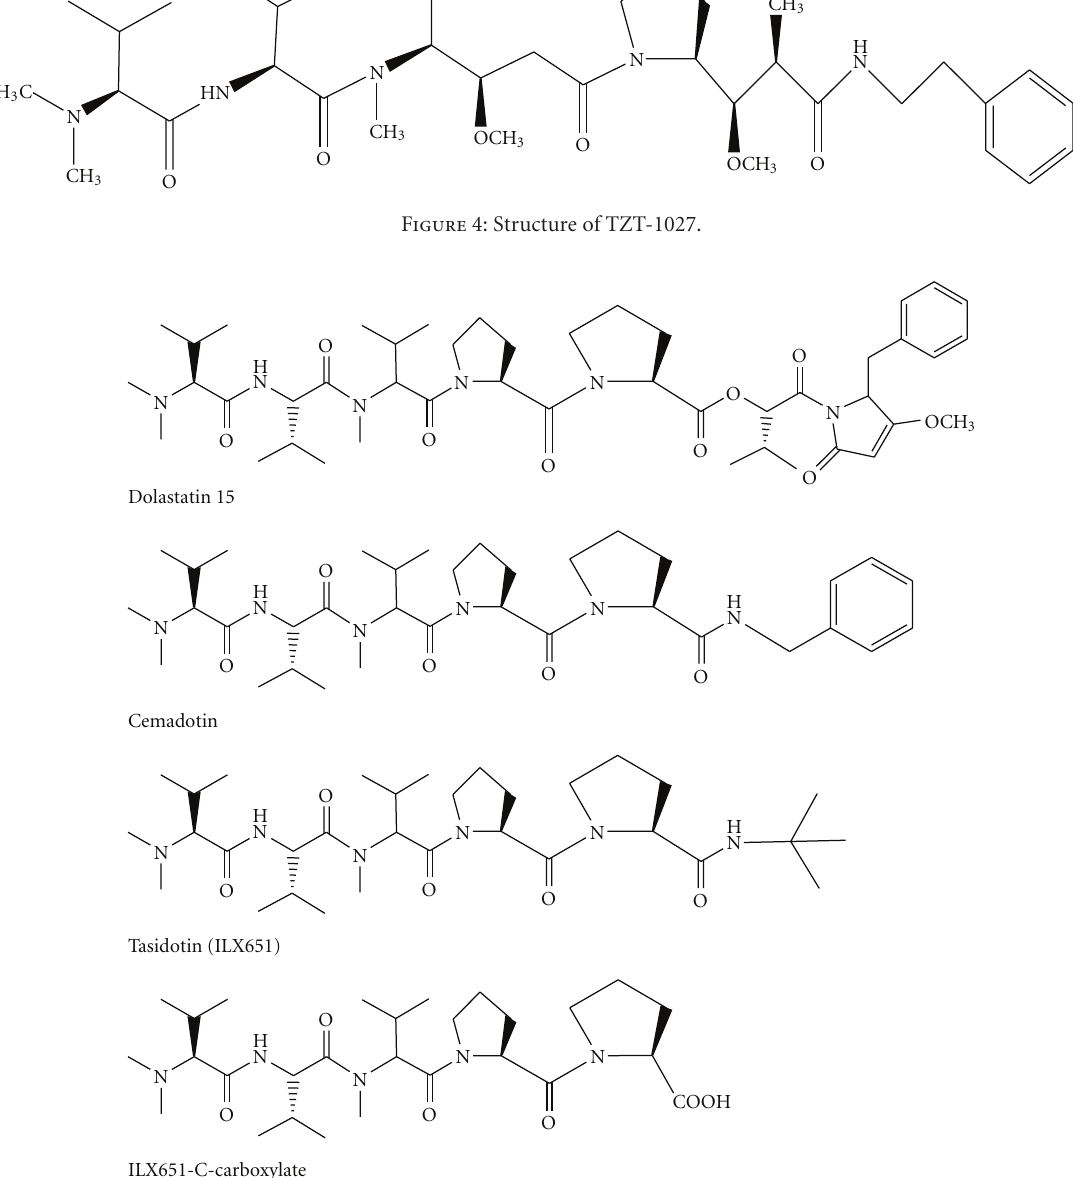
Figure 5: Structures of dolastatin-15, cemadotin, Tasidotin, and